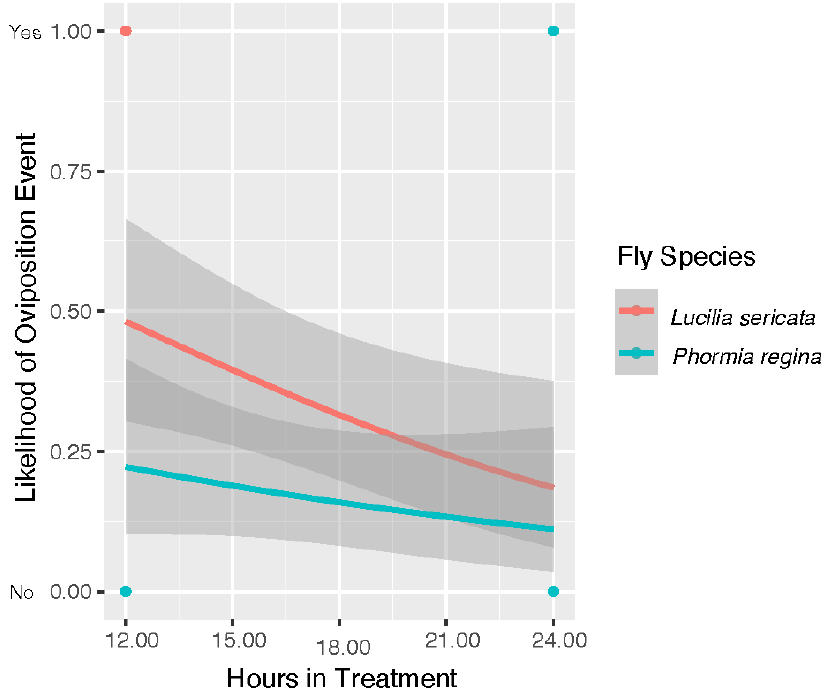
Figure 5. A plot modeling the likelihood of an oviposition event (yes/no) as time in treatment progresses. The y -axis shows the 12 h and 24 h checks when a determination of yes/no was made for oviposition events. These data indicate that both species are less likely to oviposit post 12 h in treatment at 40 °C, 42 °C, and 43 °C. In this analysis temperature ( p = 2.26 × 10 − 4 ), hour ( p = 0.009) and fly species ( p = 0.028) were all determined to be significant factors in likelihood of oviposition as time in treatment progressed.